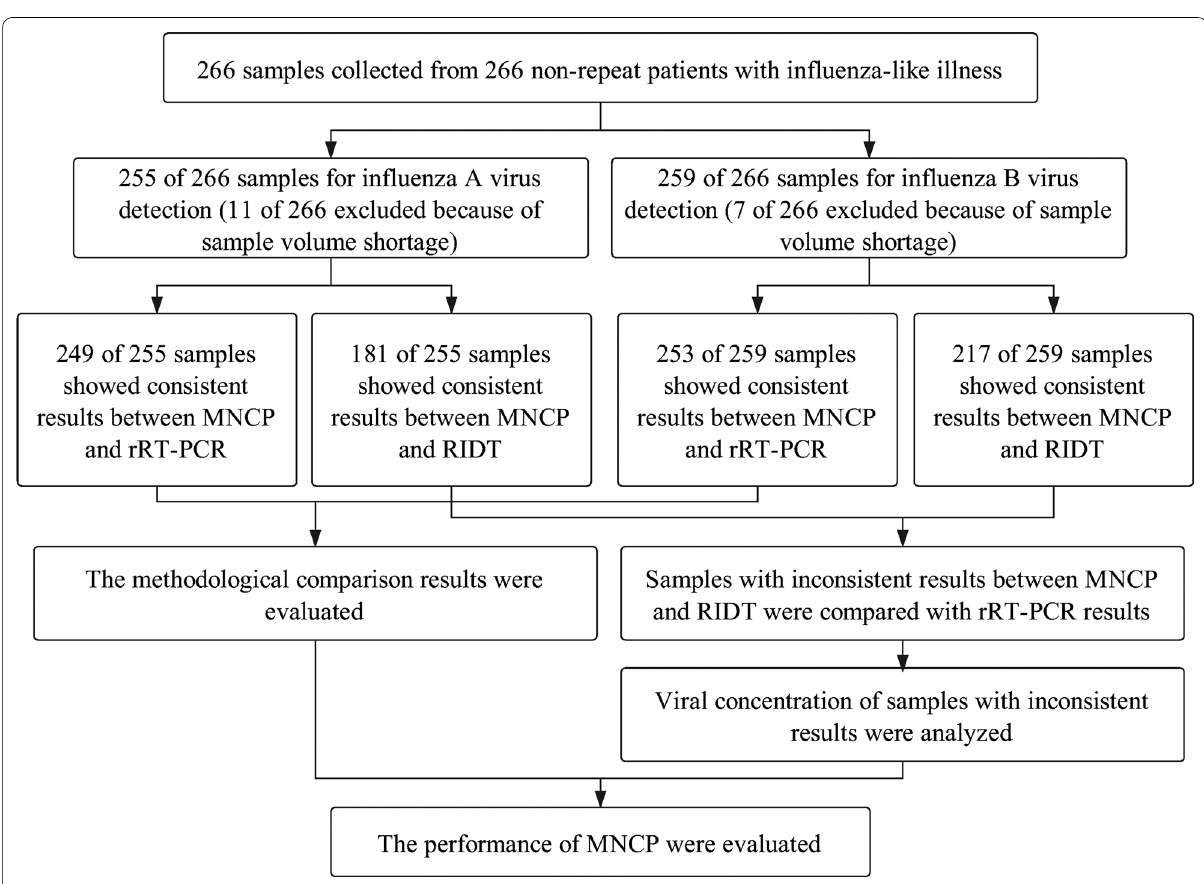
Fig. 1 Flowchart of the study. MNCP: micro/nanofluidic chip platform; RIDT: rapid influenza diagnostic test; rRT-PCR: real-time reverse transcription